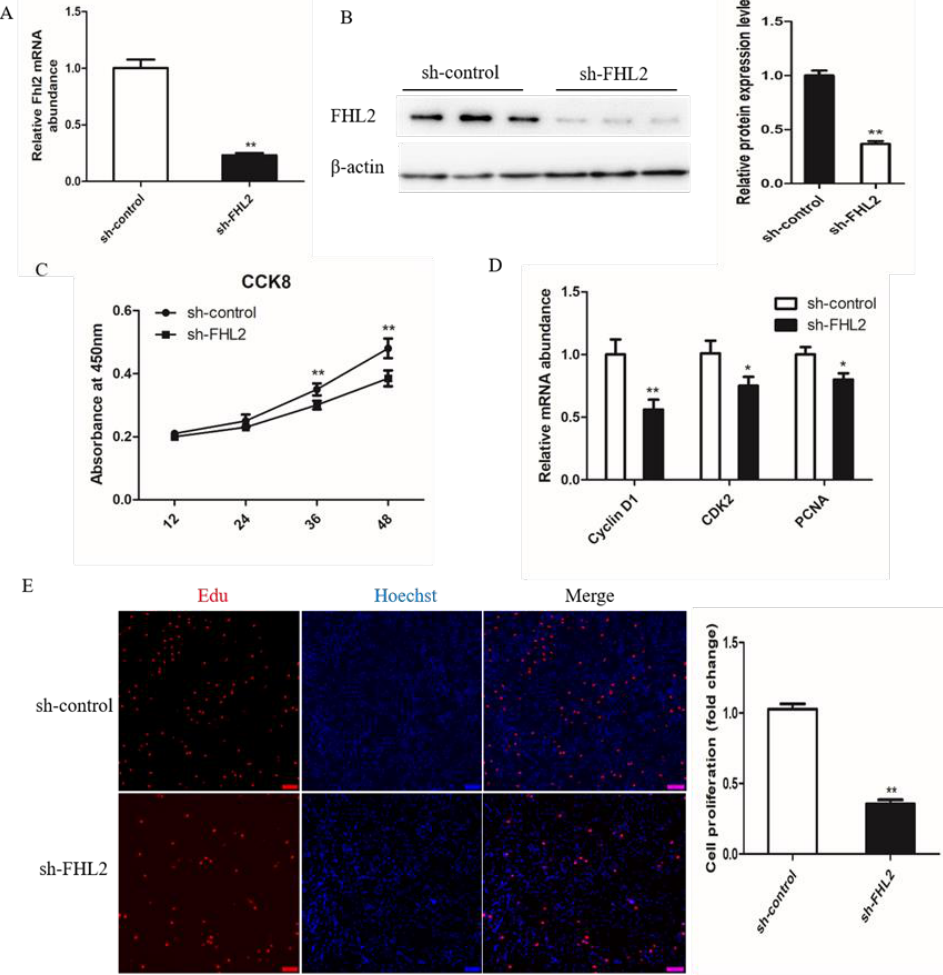
Figure 5. Effect of FHL2 knockdown on proliferation of bovine SMSCs. ( A ) Relative expression levels of FHL2 mRNA in FHL2 silenced and control cells. ( B ) Western blot analysis the protein levels of FHL2 in FHL2 silenced and control cells. ( C ) CCK8 analysis equal numbers of bovine SMSCs transfected with FHL2 shRNA and control in GM for 12, 24, 36 and 48 h. ( D ) qPCR analysis the expression levels of CyclinD1, CDK2 and PCNA in FHL2 silenced and control cells. ( E ) EdU staining of bovine SMSCs after transfected with FHL2 shRNA and control. Data are expressed as mean ± SEM ( n = 3). * p < 0.05; ** p < 0.01.